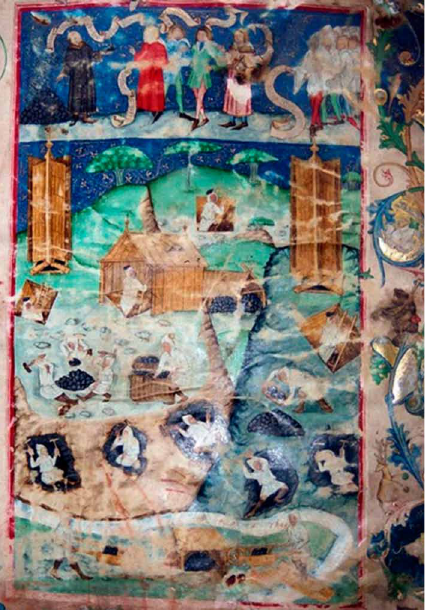
Fig. 1. Introductory page of the Kutnohorský antifonář with a picture of mining in Kutná